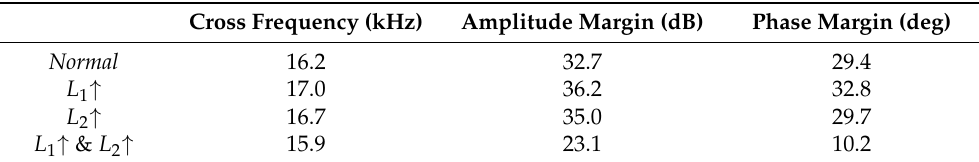
Table 2. System Stability Margins.